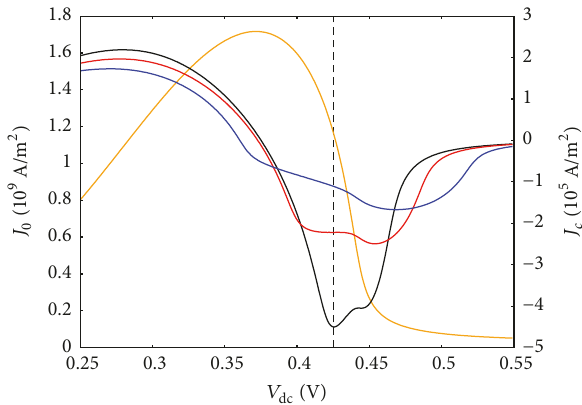
Figure 3: Direct current (solid orange line, left 𝑦 -axis) and active current 𝐽 𝑐 (right 𝑦 -axis) as a function of DC voltage for RTD heterostructure number 1 at the following frequencies: ℎ𝜔 = 4Γ (black line), ℎ𝜔 = 8Γ (red line), and ℎ𝜔 = 14Γ (blue line). Vertical dashed line indicates the area of maximum